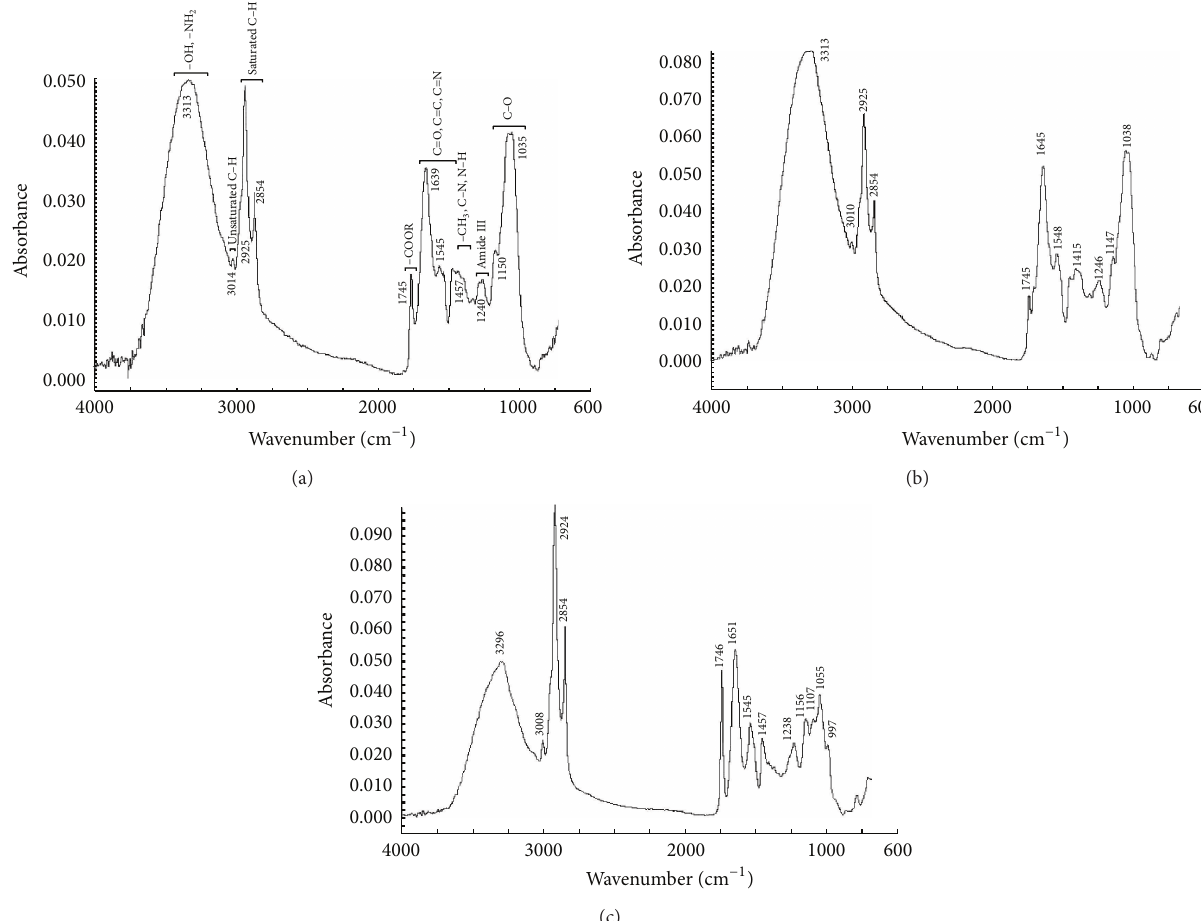
Figure 2: FT-IR spectra of (a) cuscutae semen; (b) Japanese dodder; and (c) sinapis